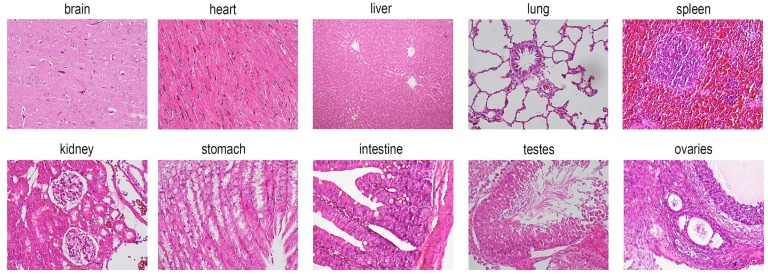
The histopathology of organs from the control group Sprague- Dawley rats (200×magnification).No significant damage was observed in the brain, heart, liver, lung, spleen, kidney, stomach, intestine, testes or ovaries of rats.